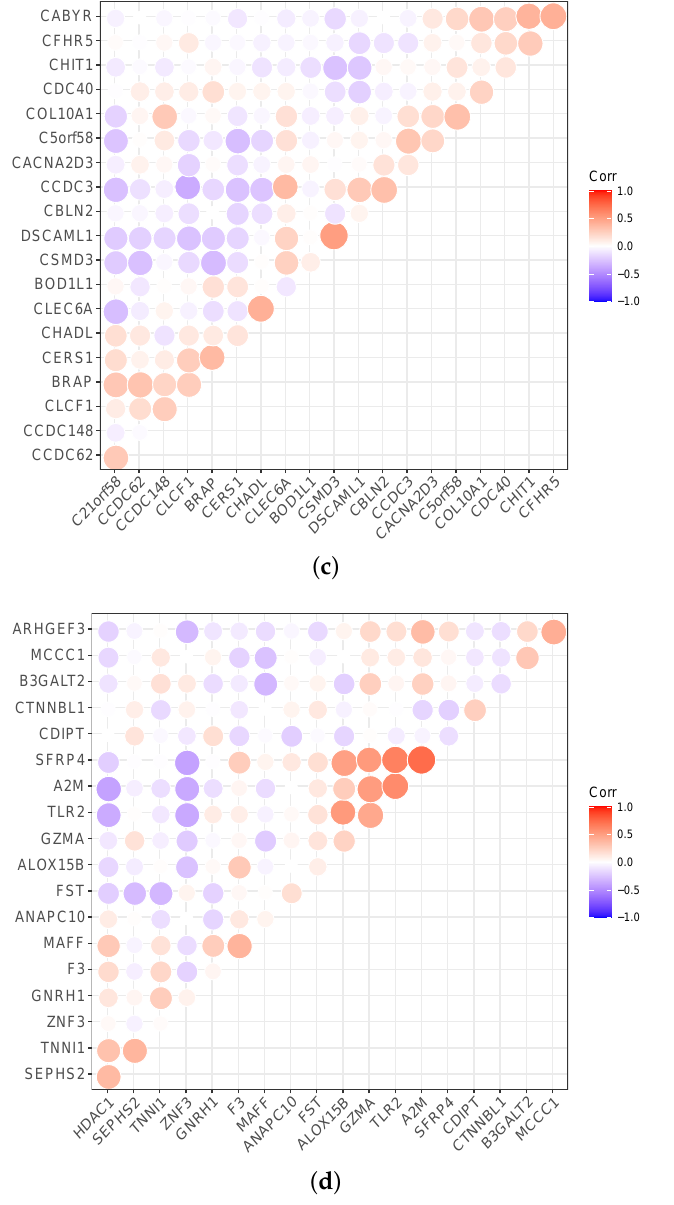
Figure 4. Relevance display via heat map for the four datasets: ( a ) BRCA (breast cancer), ( b ) CESC (cervical carcinoma cancer), ( c ) COAD (colorectal cancer), and ( d ) PAAD (pancreas